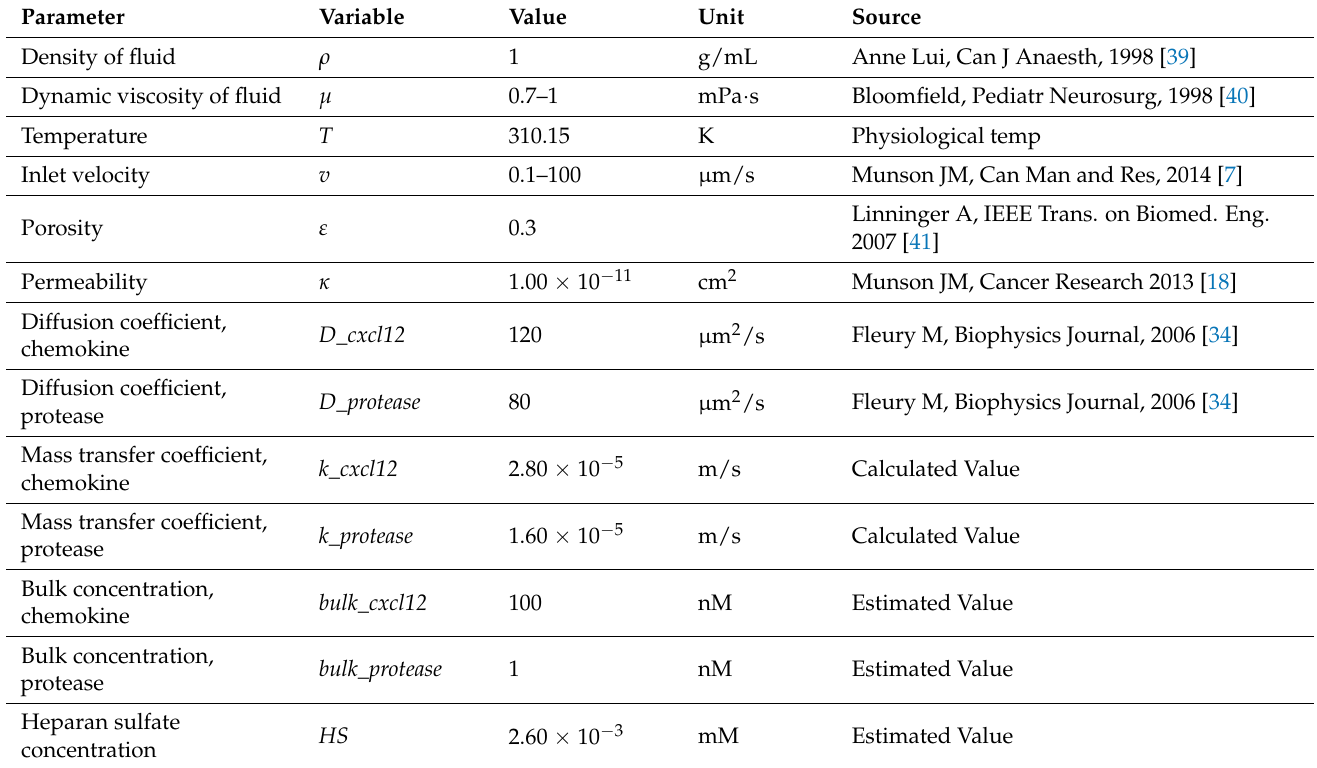
Table 1. Parameter Values for 3D computational